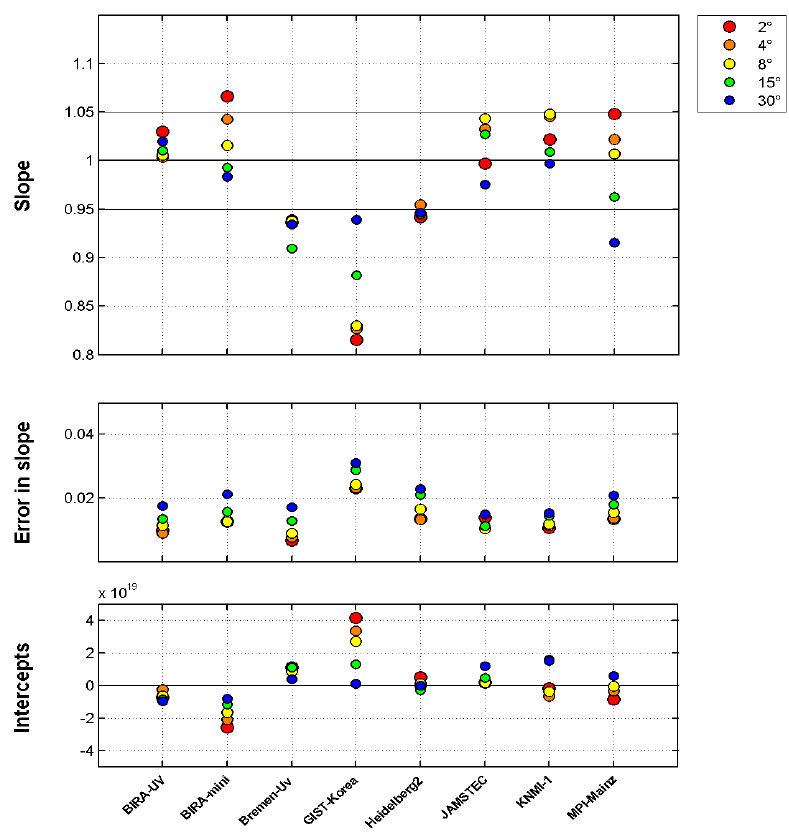
Fig. 11. Straight-line slopes and their errors of O 4 slant columns against those of the reference data set, for each instrument at UV wavelengths and for the whole campaign. Colours refer to elevation angles shown top right.